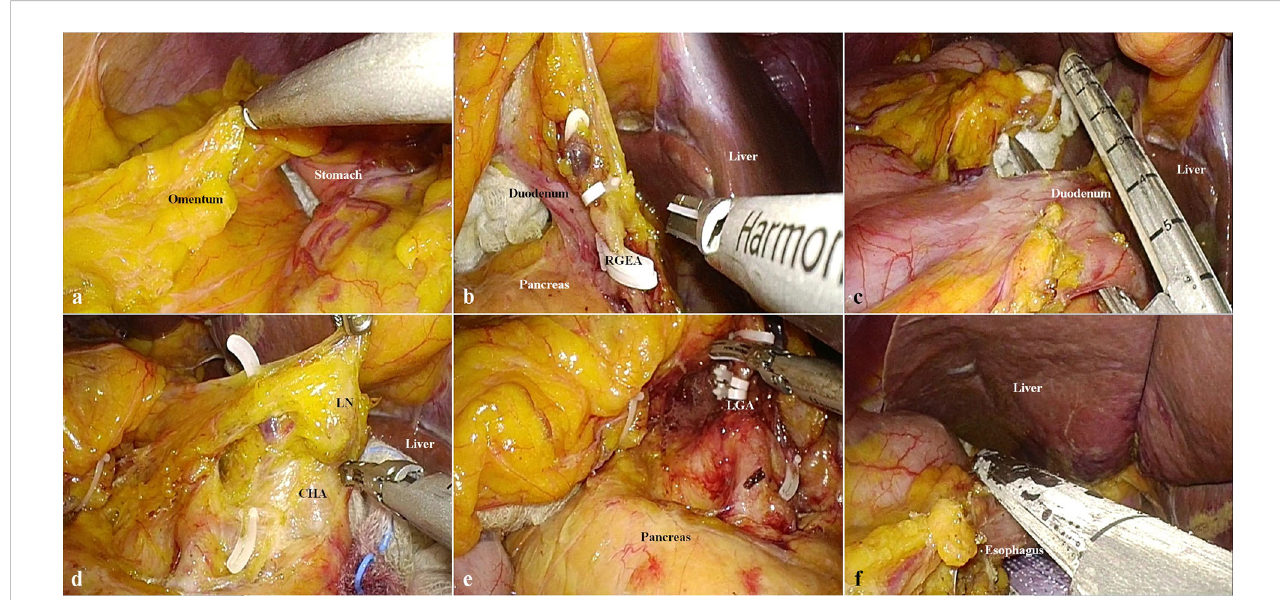
FIGURE 1 Steps of lymph node dissection. (A) Omentectomy toward the left gastroepiploic vessels. (B) Ligation and division of the left gastroepiploic vessels (RGEA, right gastroepiploic artery). (C) Division of the duodenum using a laparoscopic linear stapler. (D) Lymphadenectomy of lymph node station No. 8a (CHA, common hepatic artery; LN, lymph node). (E) Ligation and division of the left gastric artery (LGA, left gastric artery). (F) Division of the esophagus using a laparoscopic linear stapler.